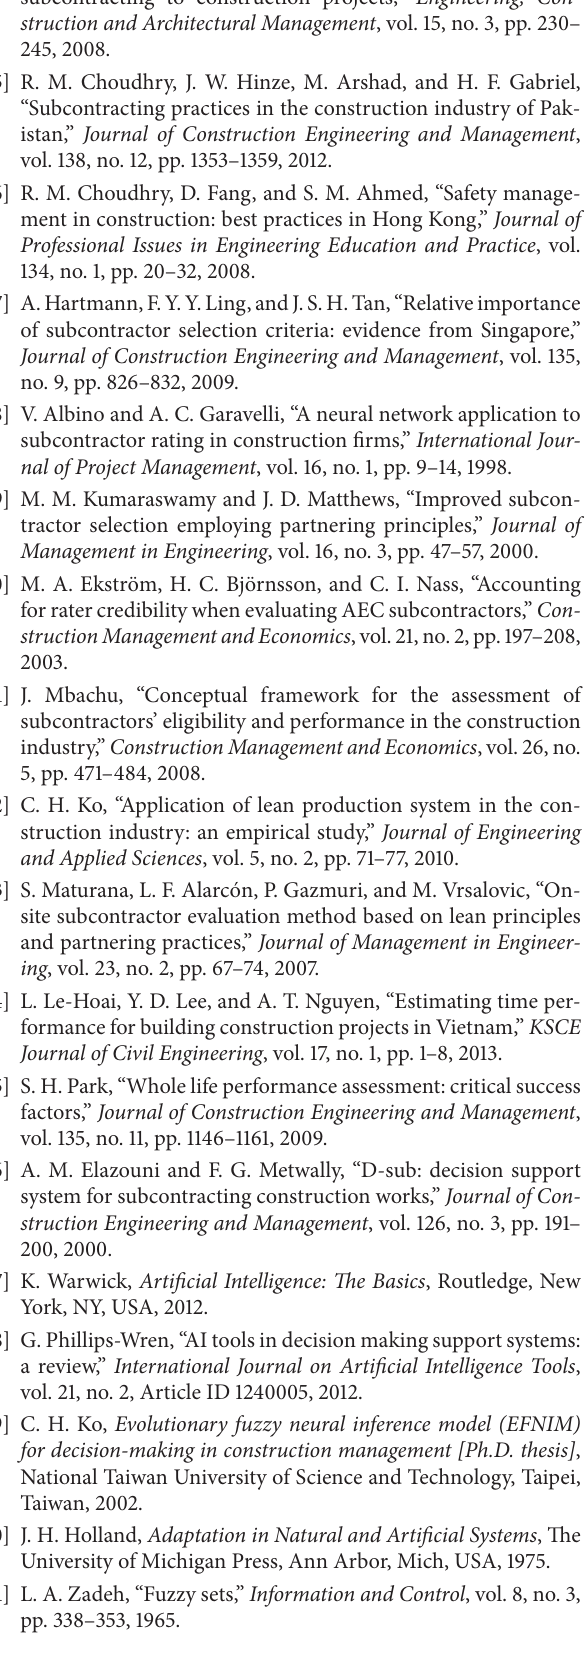
Table 3: Comparison of prediction